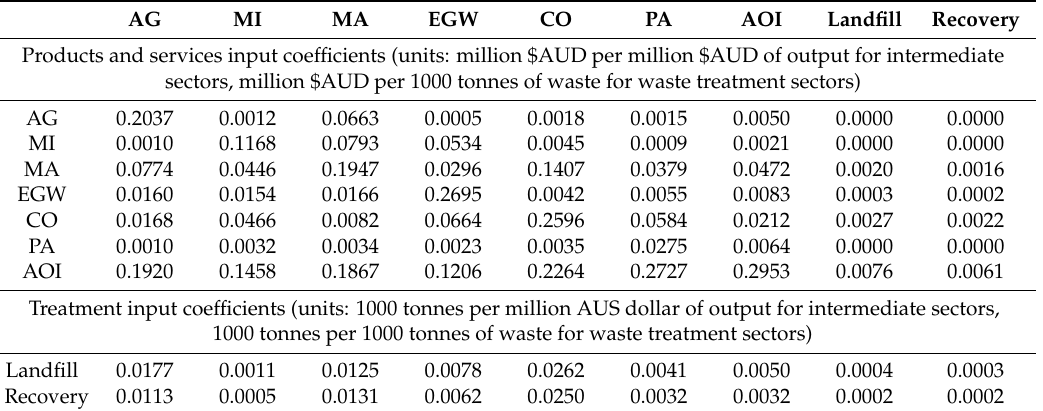
Table 8. The input coefficient matrix of Australian waste input output (WIO) table with waste treatment methods, 2009–2010.